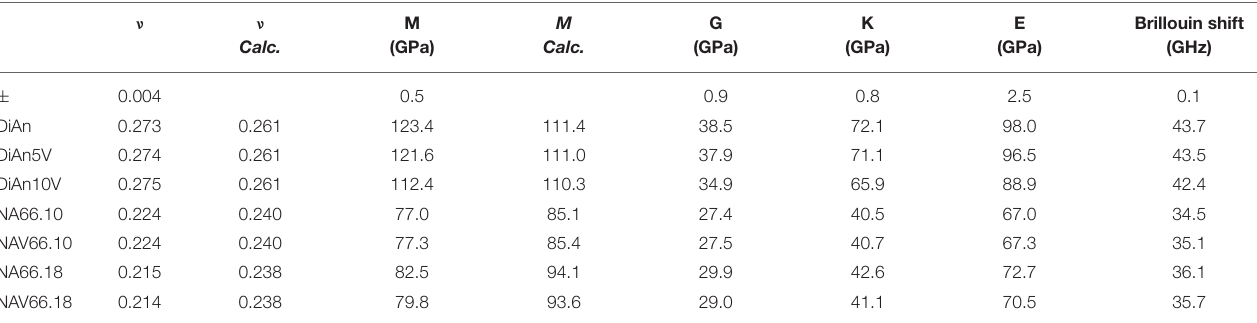
TABLE 4 | Elastic properties (GPa) and Brillouin shift (GHz) of